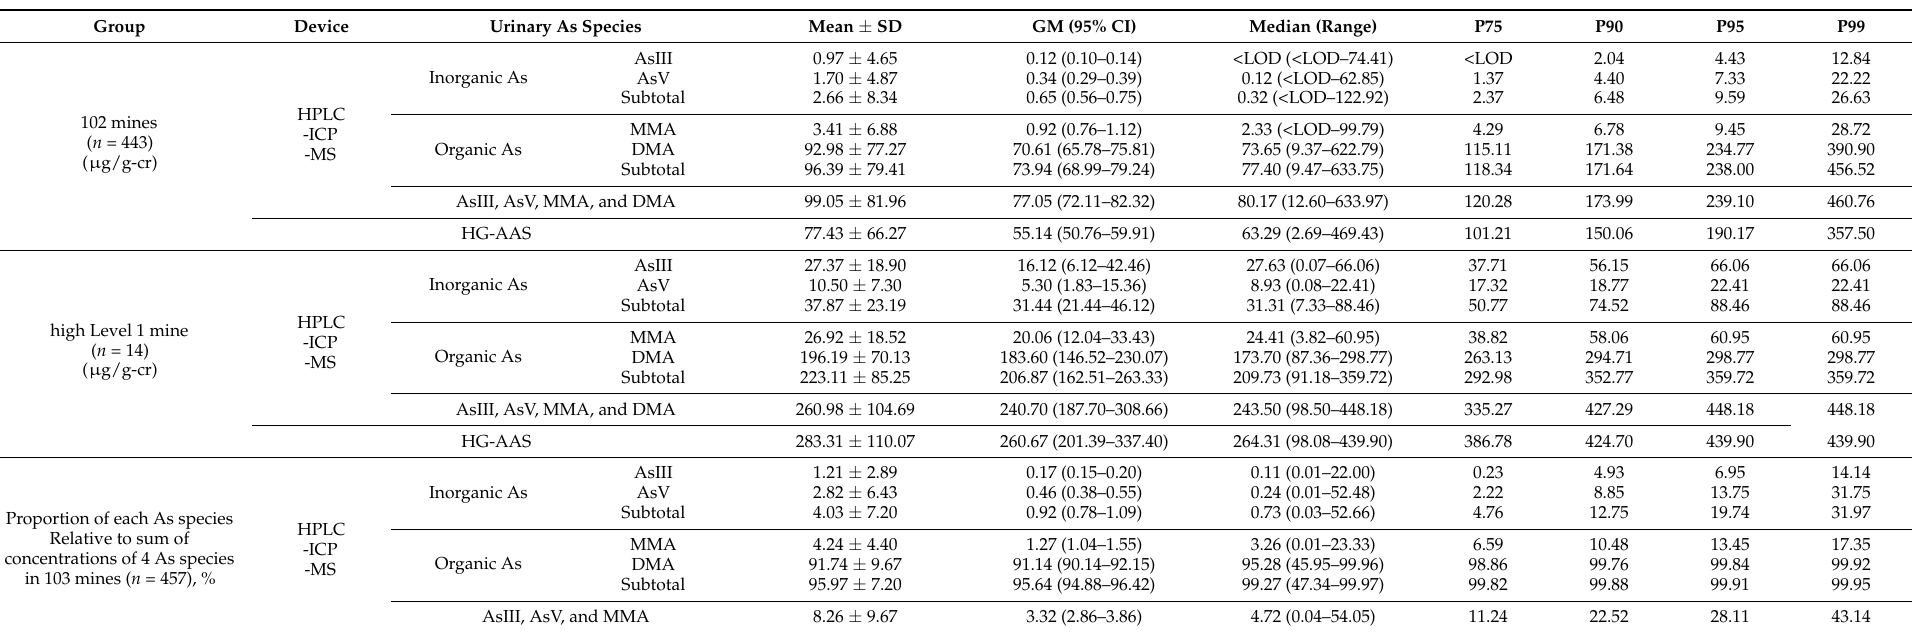
Table 1. Distribution of urinary arsenic concentration in residents living near abandoned metal